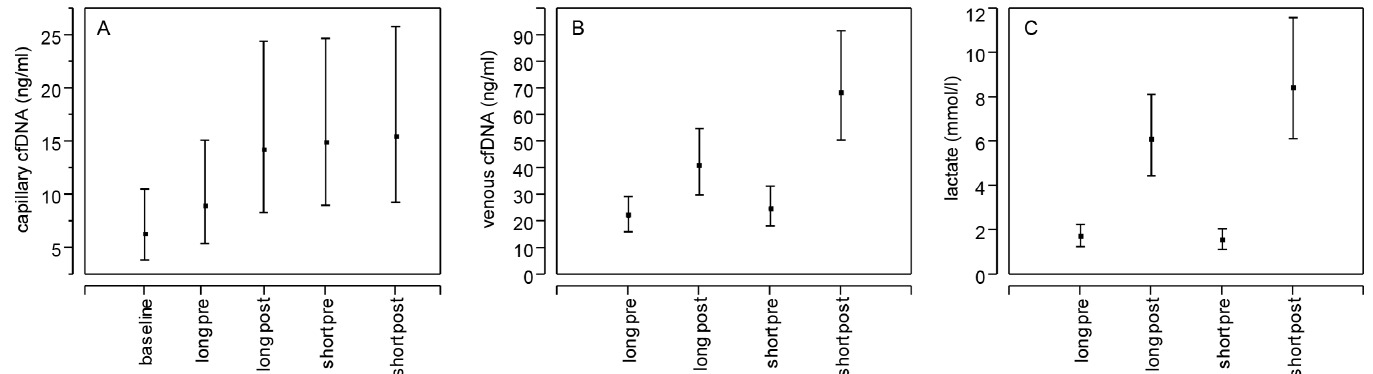
Fig 2. CfDNA and lactate concentrations in sprint series with short and long pauses. Concentrations of capillary cfDNA (A), venous cfDNA (B) and lactate (C) in athletes before and directly after five sprints with 1 minute pauses (short pre and post) and 5 minutes pauses (long pre and post). Significant difference between both sprint series in lactate (p = 0.031) and venous cfDNA (p = 0.016). Shown are the mean values and 95% confidence